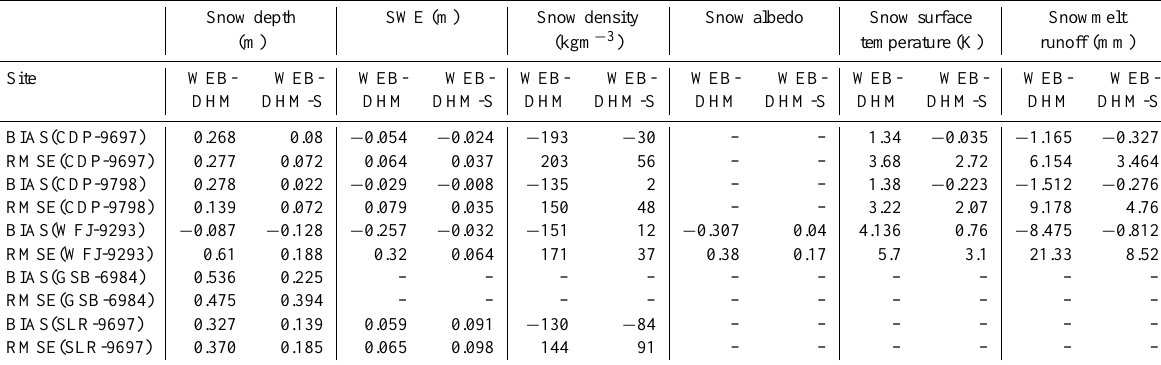
Table 3. BIAS and RMSE for the SnowMIP1